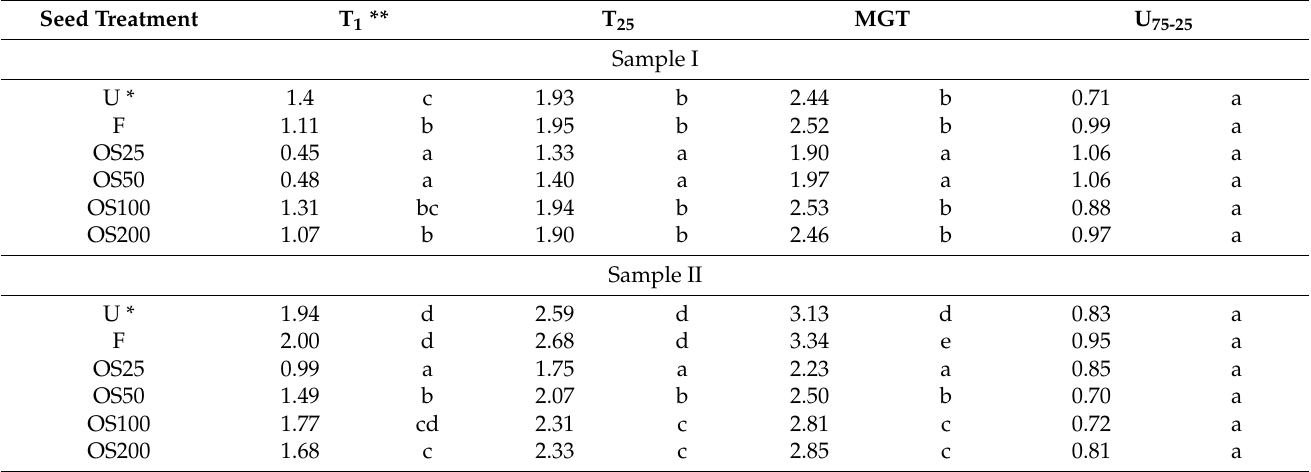
Table 2. Effects of osmopriming with the addition of melatonin on the speed and uniformity of D. carota ‘Amsterdamska’ seed germination